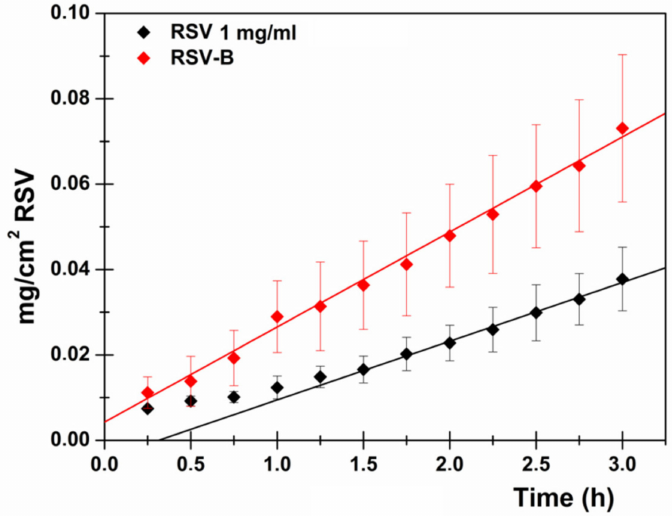
Figure 6. RSV (mg/cm 2 ) permeated as a function of time (h) after administration of 1 mg/mL RSV solution (black) and RSV-B mini-tablet